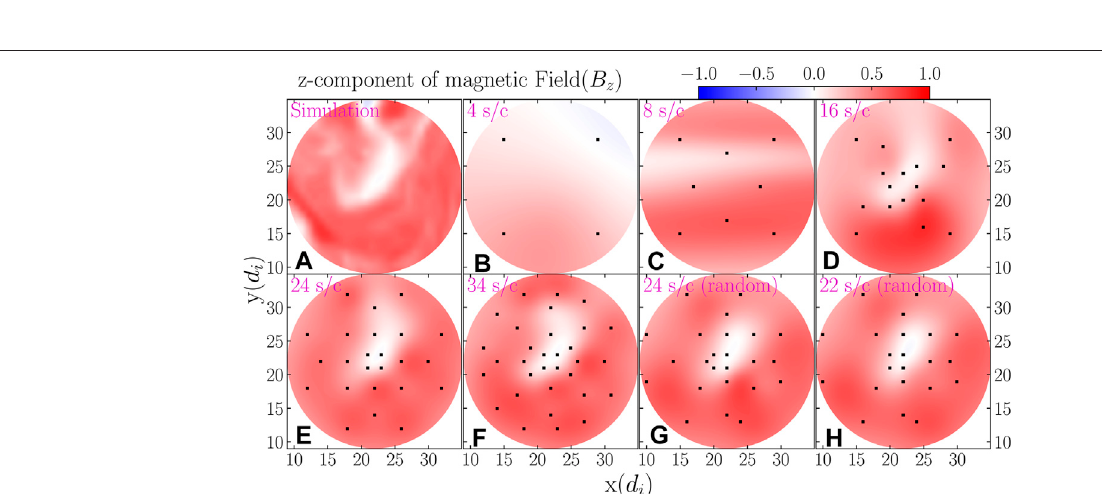
Frontiers in Astronomy and Space Sciences |